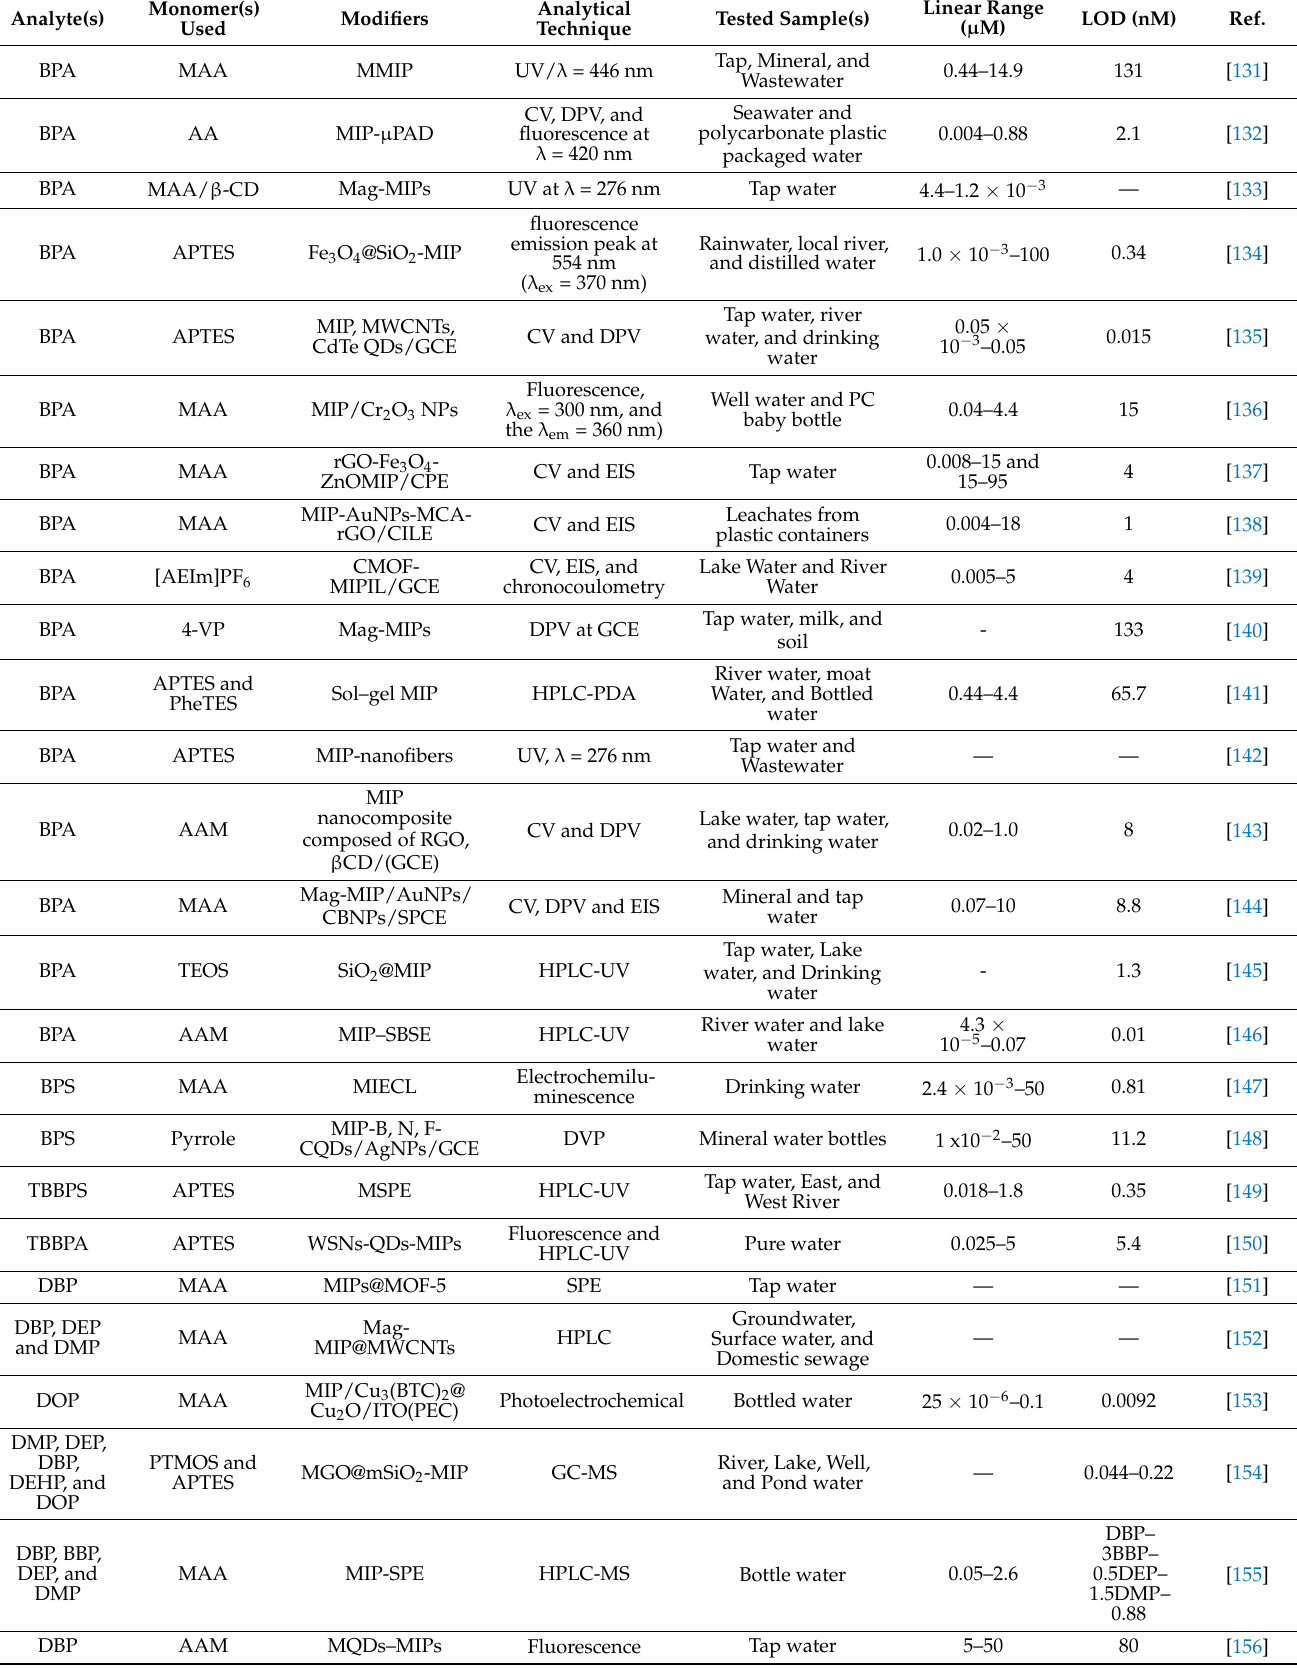
Table 4. Application of MIPs for the determination of selected endocrine disrupting compounds in waters and wastewaters.